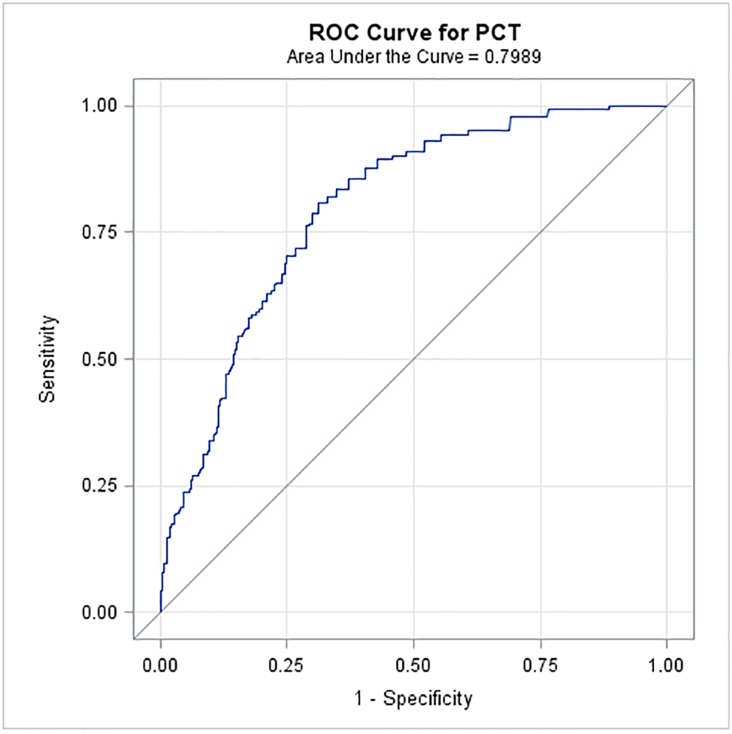
Patients Flow Chart.